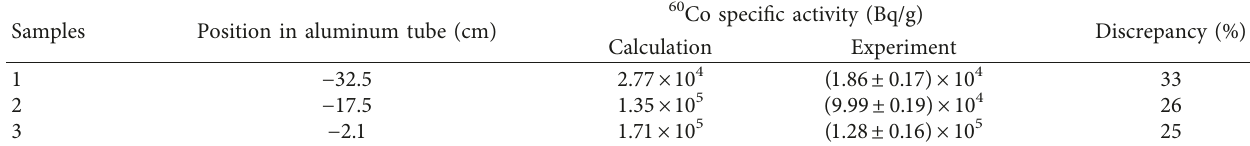
Table 3: Activity of 60 Co isotope in the guiding tube of irradiation channel 13-2. Samples